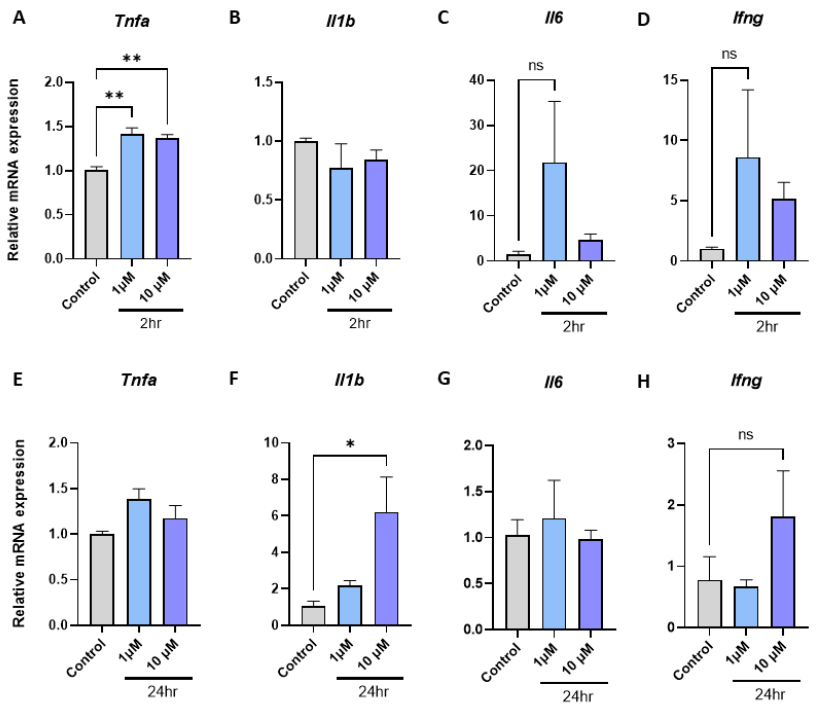
Figure 1. Metformin elicits direct proinflammatory gene expression in BMDM in a time- and dose- dependent manner. ( A – D ) Metformin 2 h, ( E – H ) metformin 24 h ( n = 3–4 per group, one-way ANOVA, data are mean ± SEM, * p ≤ 0.05, ** p ≤ 0.01 relative to control, ns; not significant).